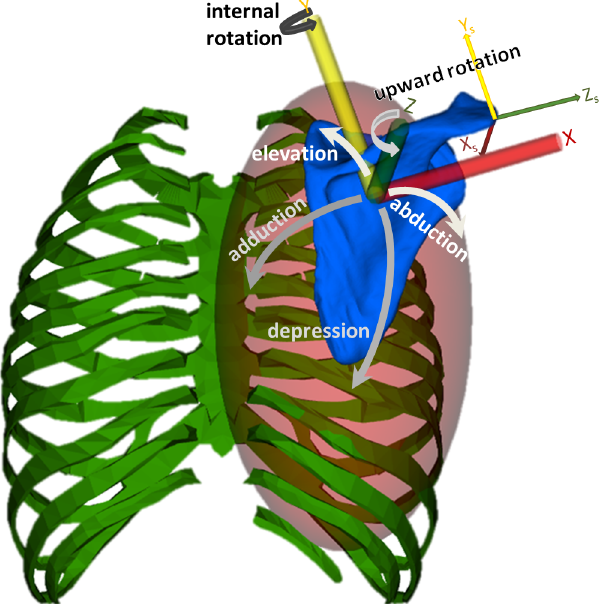
Fig 1. The four modeled degrees of freedom of the scapulothoracic joint. The joint reference frame on the scapula (axes X,Y,Z) is used to locate the scapula with respect to the thorax. The joint reference frame on the scapula is computed according to the ISB recommendations [18] (shown as X S , Y S , Z S ), however our joint origin is located at the centroid of the anatomical markers used to define the joint frame instead of the Angulus Acromialis and its axes are rotated -90° about Y (to enable positive upward rotation about Z). The joint frame on the thorax defines the center of the scapulothoracic surface modeled as an ellipsoid (red shaded surface). Abduction (adduction) followed by elevation (depression) locate the joint frame origin of the scapula (blue) on the ellipsoid fixed to the parent thorax body (green). The scapula rotates upward (downward) about the normal to the surface (scapula Z-axis). Internal rotation or “ winging ” is a positive rotation about the Y-axis of the joint frame in the scapular plane, which remains tangent to the thoracic